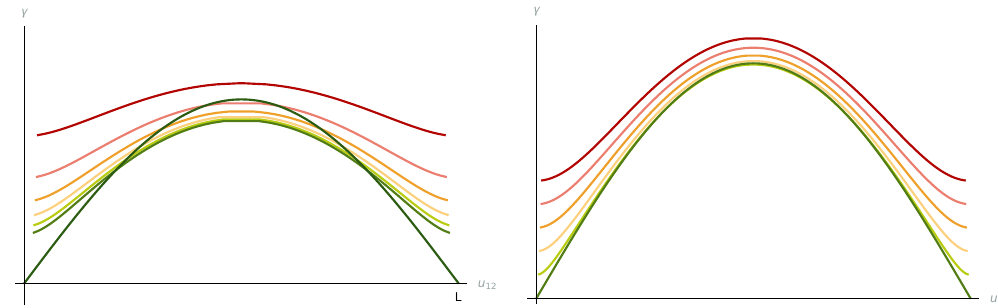
Figure 15 . (cid:13) ( u 12 ) for various values of the boundary dilaton compared to the conformal answer. The curves become greener as (cid:15) decreases. The renormalized dilaton (cid:30) r on the right is larger than on the left, and the result is accordingly close to the